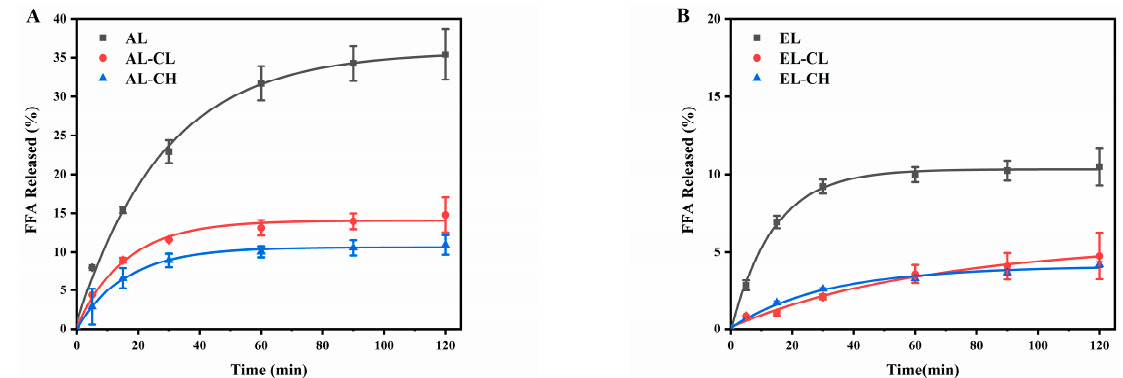
Figure 1. Free fatty acids (FFA) released from different emulsions during in vitro intestinal digestion of ( A ) adult and ( B ) infant. Data were shown as mean ± SD of three replicates. AL, in vitro adult digestion without chlorophyll; AL-CL, in vitro adult digestion with lower dose of chlorophyll (0.24%, w / w ); AL-CH, in vitro adult digestion with higher dose of chlorophyll (0.50%, w / w ); EL, in vitro infant digestion without chlorophyll; EL-CL, in vitro infant digestion with lower dose of chlorophyll (0.24%, w / w ); EL-CH, in vitro infant digestion with higher dose of chlorophyll (0.50%, w / w ). To further investigate the role of chlorophyll in lipids digestibility, Equation (2) was used to analyze the linear relationships between FFA release and digestion time. Table 1 provided the curve-fitting parameters, including apparent rate constants ( k ) and regression coefficients. All FFA release curves had good linear correlations (all above 0.9000). The presence of chlorophyll made the apparent rate constant smaller, indicating that chlorophyll could reduce the degree of hydrolysis and the rate of lipids digestion. A similar result reported that cellulose-nanoparticles-stabilized emulsions with a higher FFA release rate (0.029 min − 1 ) showed a great impact on lipolysis rate